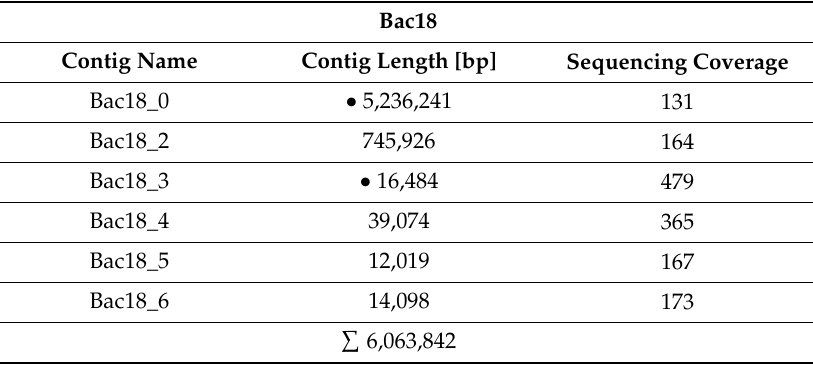
Table 1. Assembly statistics for Bac18. Circularized contigs are marked with • .